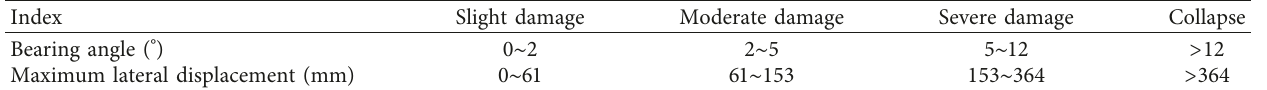
Figure 5: Simplified pressure distribution: (a) trapezoidal load distribution; (b) real pressure history; (c) simplified pressure Table 3: The failure criterion of an RC pier.